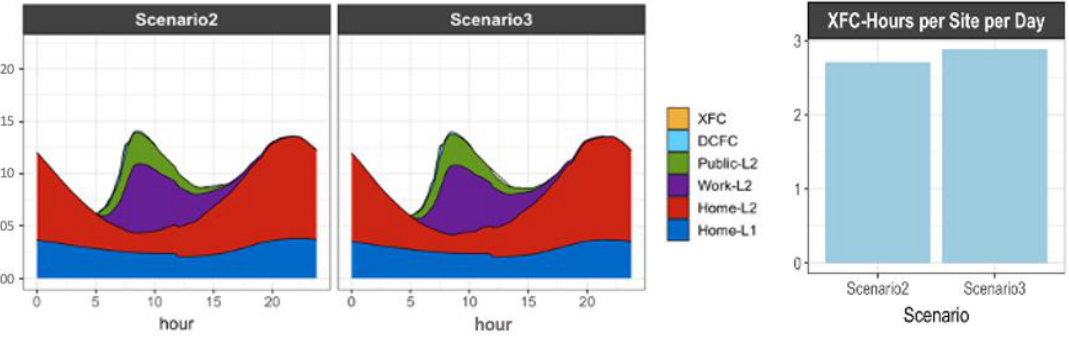
Figure 4. The charger type balances and ratios of extreme fast charging use for scenario 2 and scenario